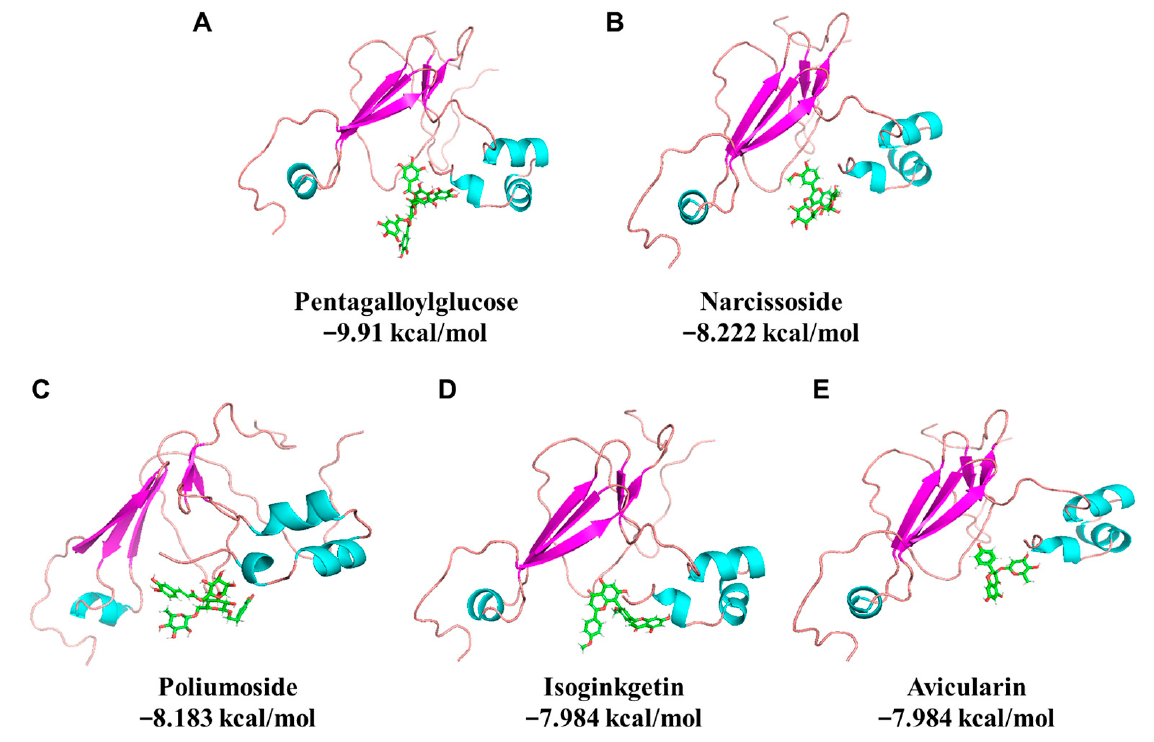
Figure 1. The stereo views of leading phytochemical–11S complexes from virtual screening. ( A ) Pentagalloylglucose, ( B ) narcissoside, ( C ) poliumoside, ( D ) isoginkgetin, ( E ) avicularin.